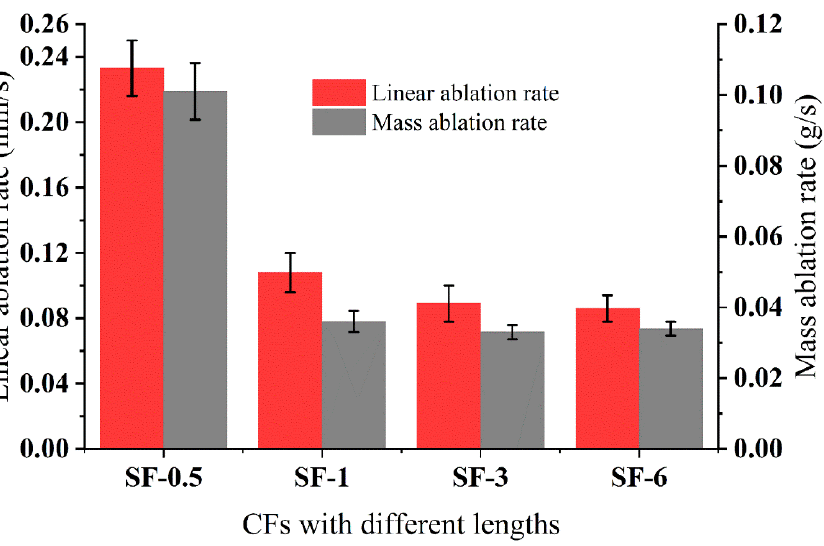
Figure 4. Linear ablation rate and mass ablation rate for the composites with different lengths of